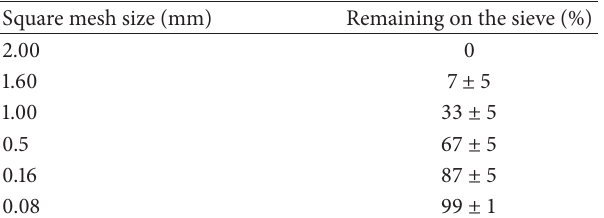
Table 3: Gradation of standard sand, according to national standard no.